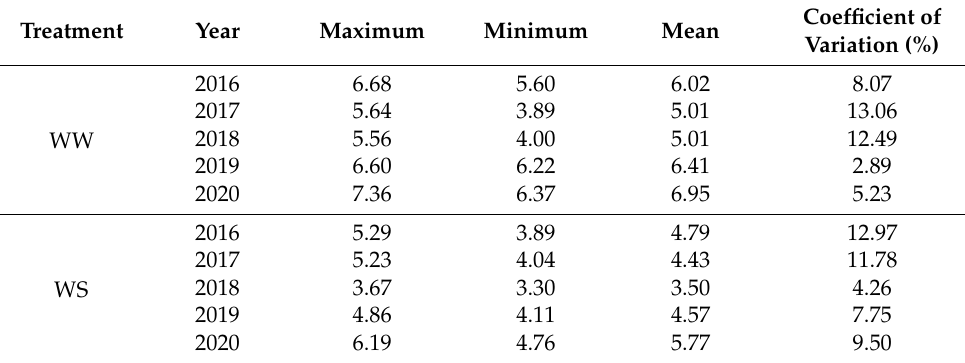
Table A4. The maximum, minimum, mean and coefficient of variation of grain yield of different varieties in five